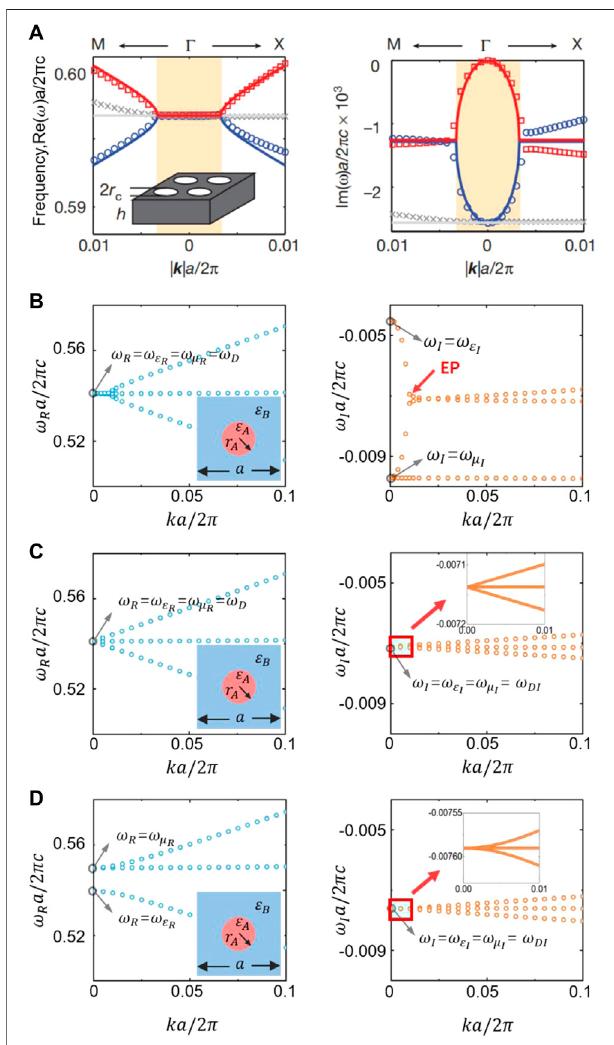
FIGURE3|(A) The real (left panel) and imaginary (right panel) parts of the eigen-frequencies of a PhC slab with fi nite thickness. By tuning the radius, accidental degeneracy in the real part can be achieved, but the Dirac-like cone is deformed into a 2D fl at band enclosed by a ring of EPs. Reproduced with permission from Ref. [136] [ (B – D) ] The real (left) and imaginary (right) parts of the eigen-frequencies of a 2D non-Hermitian PhC consisting of a square lattice of cylindrical rods, showing (B) the ring of EPs, (C) complex Dirac-like cone with conical dispersions in both real and imaginaryfrequencyspectra,and (D) thequadraticdegeneracy.Therelative permittivitiesoftherods(orbackgroundmedium)are12 . 5 + 0 . 5 i (or1)in (B) , 12 . 5 + 0 . 33 i (or1 + 0 . 0264 i )in (C) ,and12 + 0 . 33 i (or1 . 04 + 0 . 02978 i )in (D) . Reproduced with permission from Ref. [155].